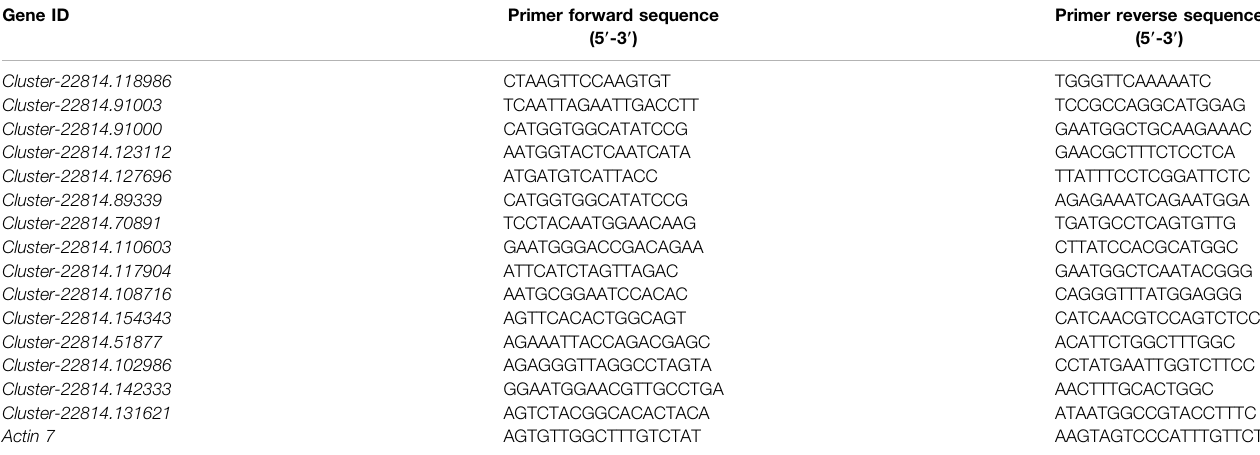
TABLE 2 | List of primers used for qRT-PCR analysis of the selected ginger genes in different tissues. Gene